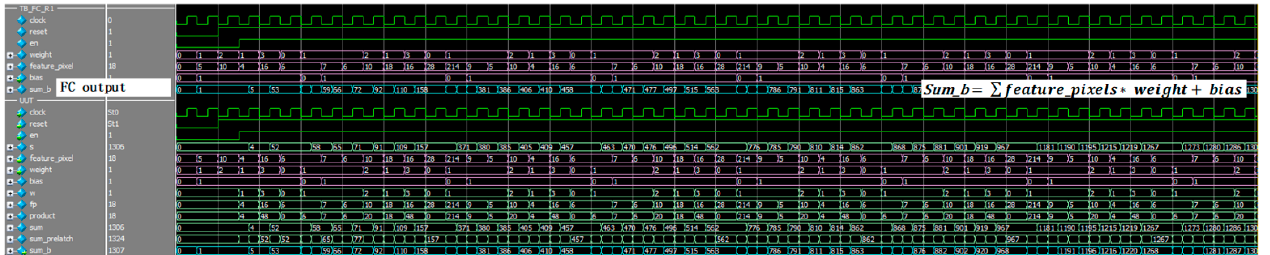
Figure 18. The simulation result of the max-pooling operation.